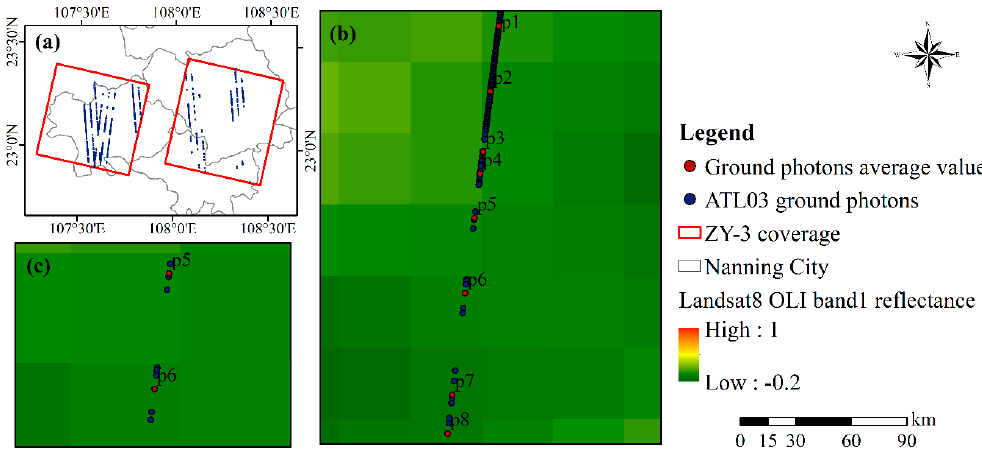
Figure 5. Examples of locations of ground photons and ground photon average values within a 30 m × 30 m grid. Grid division is based on the row and column IDs of Landsat 8 data. The scale bar at the bottom right of the image matches that shown in ( a ). ( a ) shows the spatial distribution of ATL03 ground photons and ZY-3 data, and ( b , c ) are the positions of ground photons average value and ground photons in each pixel.